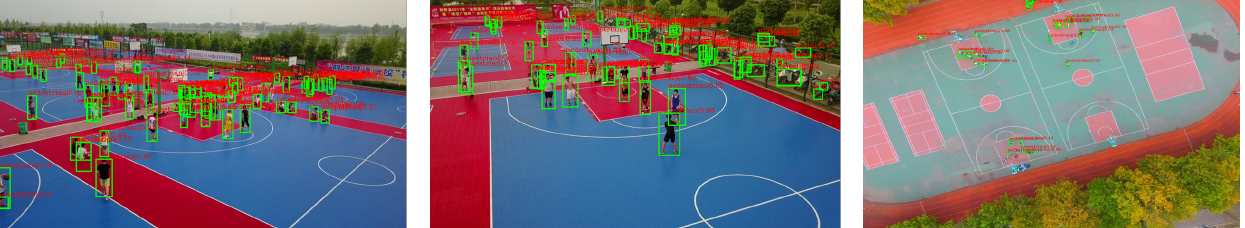
Figure 11. The results of our detection framework on the VisDrone2020